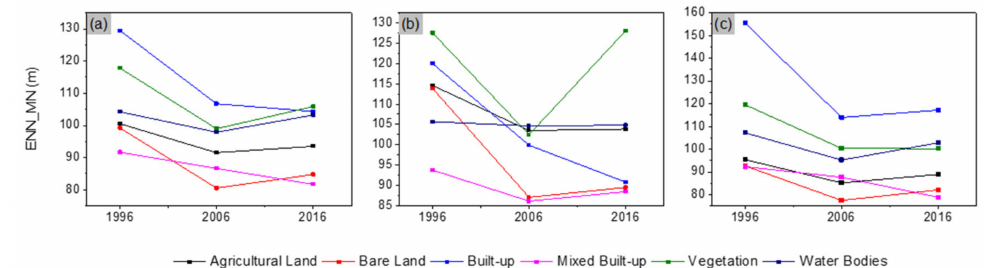
Figure 13. Class level ENN_MN; ( a – c ) present temporal dynamics of class level ENN_MN in KMA, KMA-urban, and KMA_rural, respectively, in 1996, 2006, and